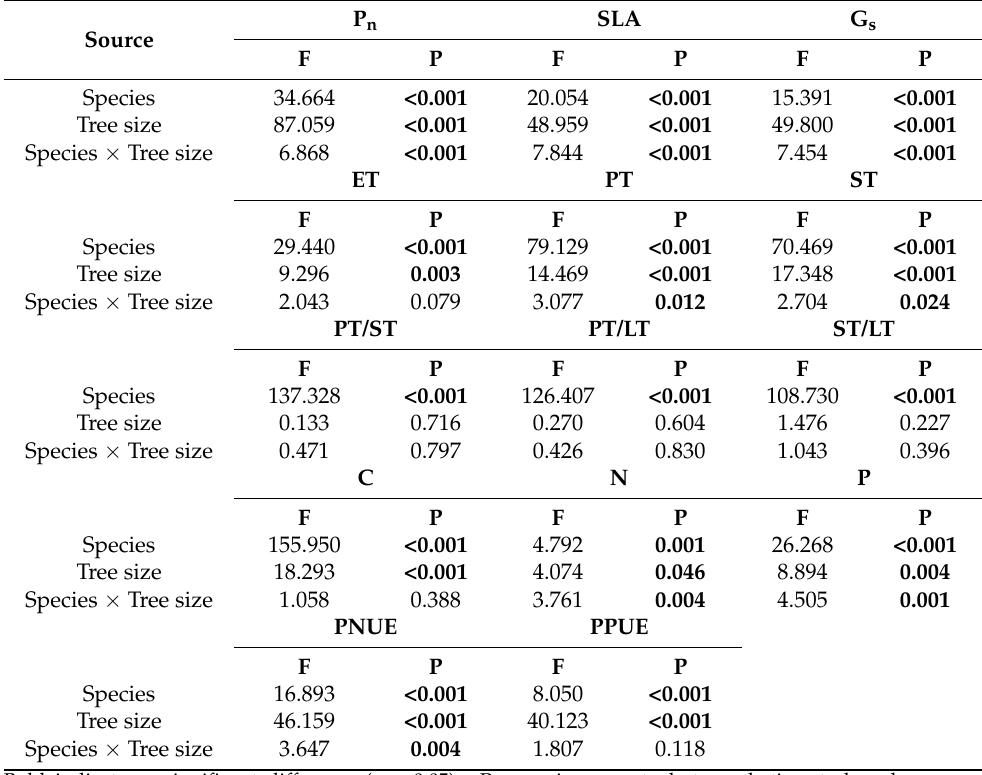
Table 2. Effect of species and tree size on leaf traits. Source